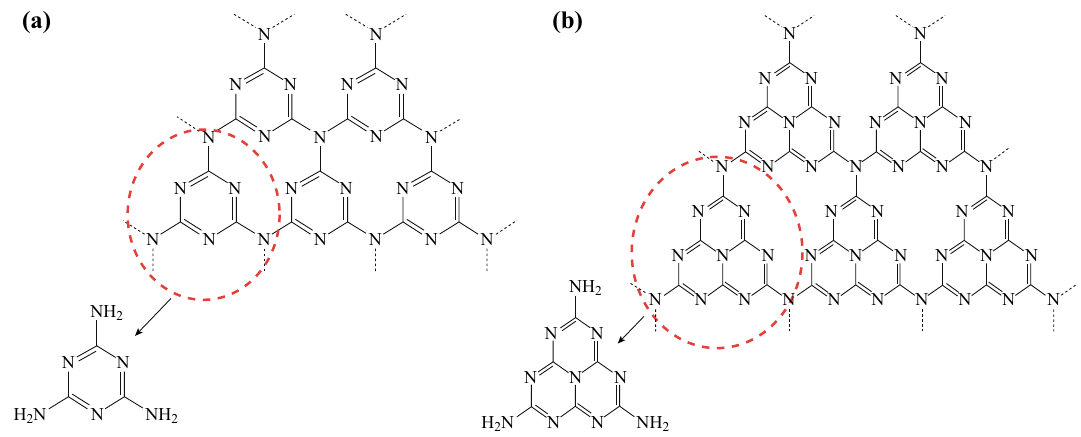
Fig. 1 a Triazine and b tri-s-triazine (heptazine) structures of g-C 3 N 4 . Reprinted with permission from Ref. [40]. Copyright 2016 American Chemical